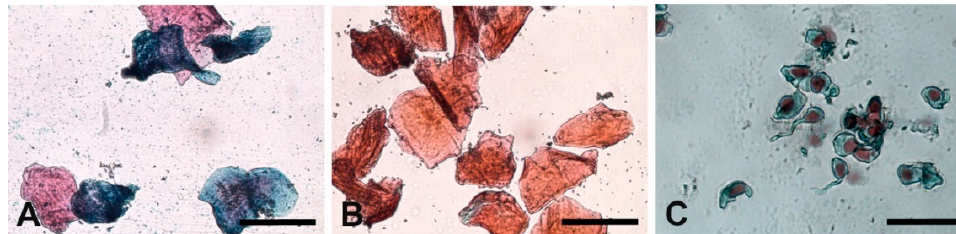
Figure 4. Vaginal cytology feature of the baboon Papio hamadryas during the menstrual cycle. ( A ) follicular phase; ( B ) preovulatory phase; ( C ) luteal phase. Harris–Shorr staining. Scale bars: ( A – C ) = 50 μ m.